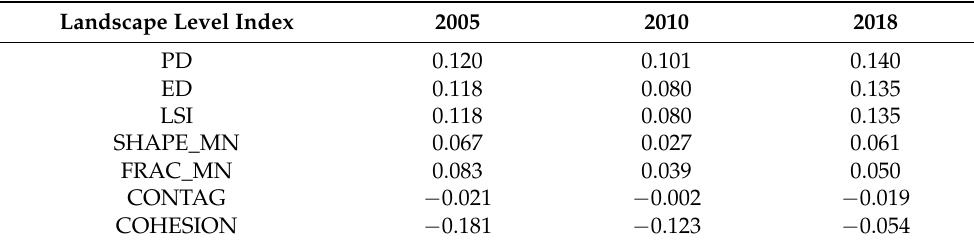
Table 7. Global Moran’s I of ESV and landscape level pattern index.